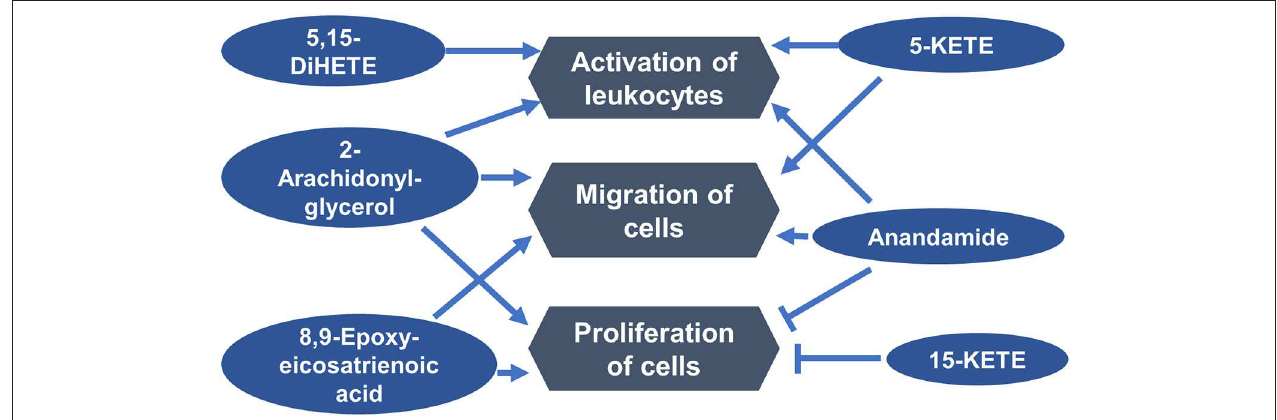
FIGURE 5 | Luteal metabolomics during maternal recognition of pregnancy ( N = 4/group). Lipids that changed (15-KETE; P < 0.05) or tended to change ( P < 0.1) during maternal recognition of pregnancy.